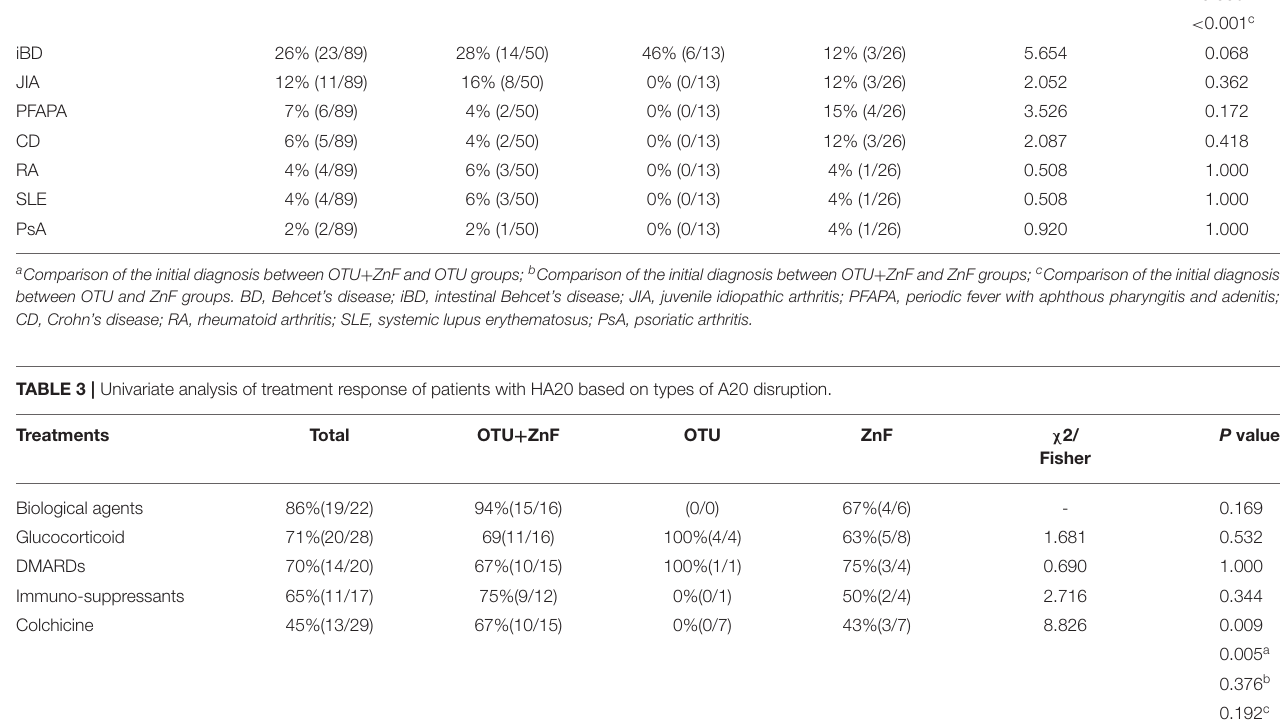
Biological agents Glucocorticoid